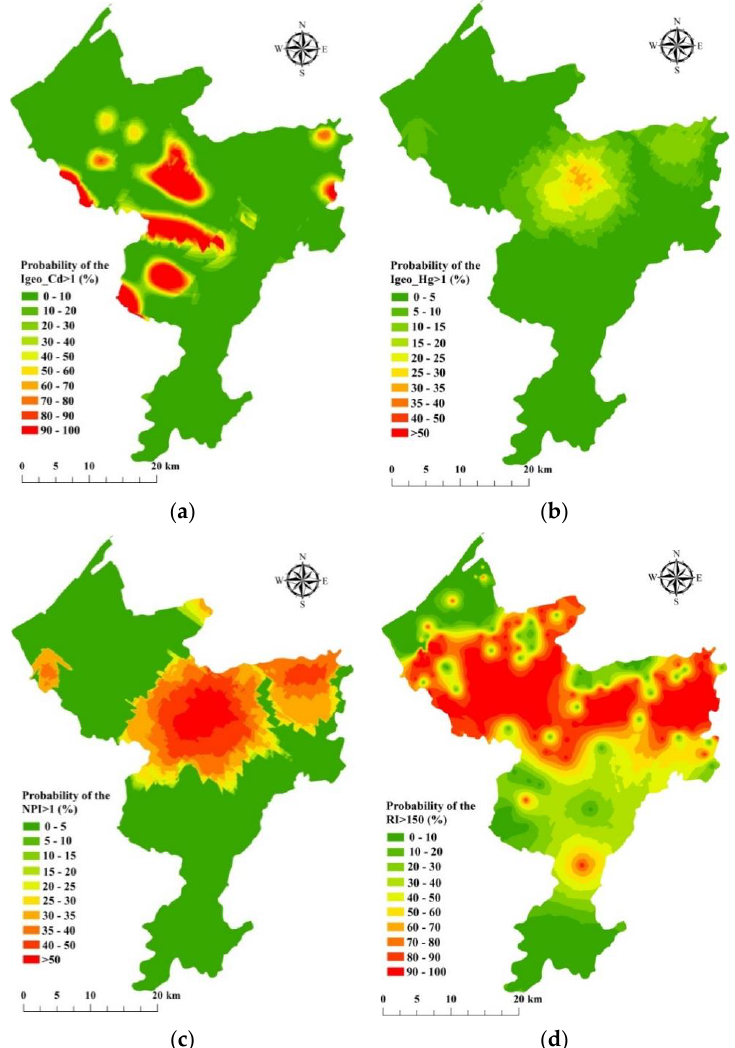
Figure 6. Map of probability of the I geo value for Cd and Hg >1 ( a , b ), probability of the NPI value >1 ( c ), and probability of the RI value >150 ( d ).